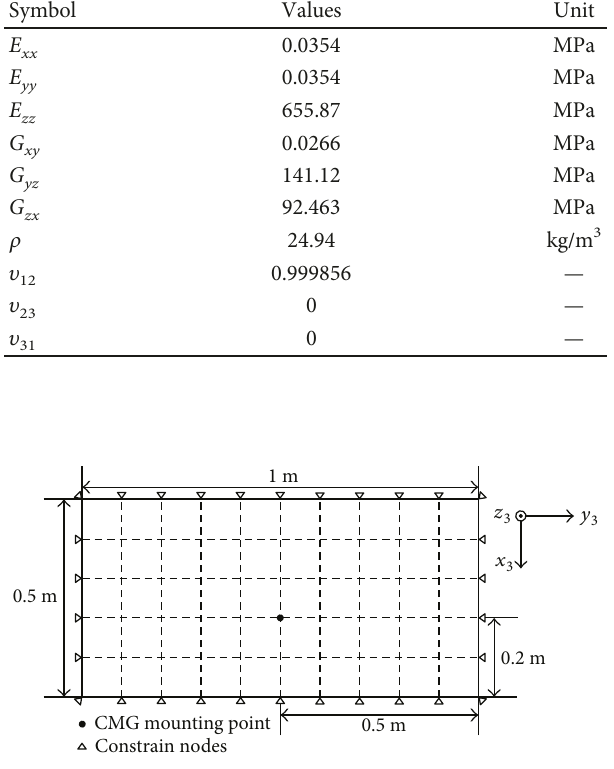
Figure 12: Schematic diagram of FEM of the AHSP.